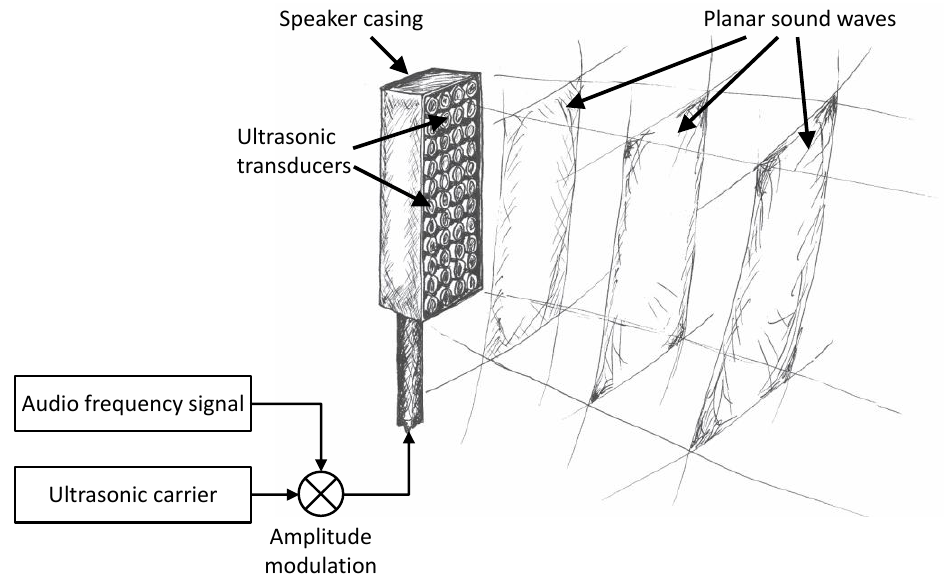
Figure 6. Conceptual drawing and block diagram of an ultrasonic